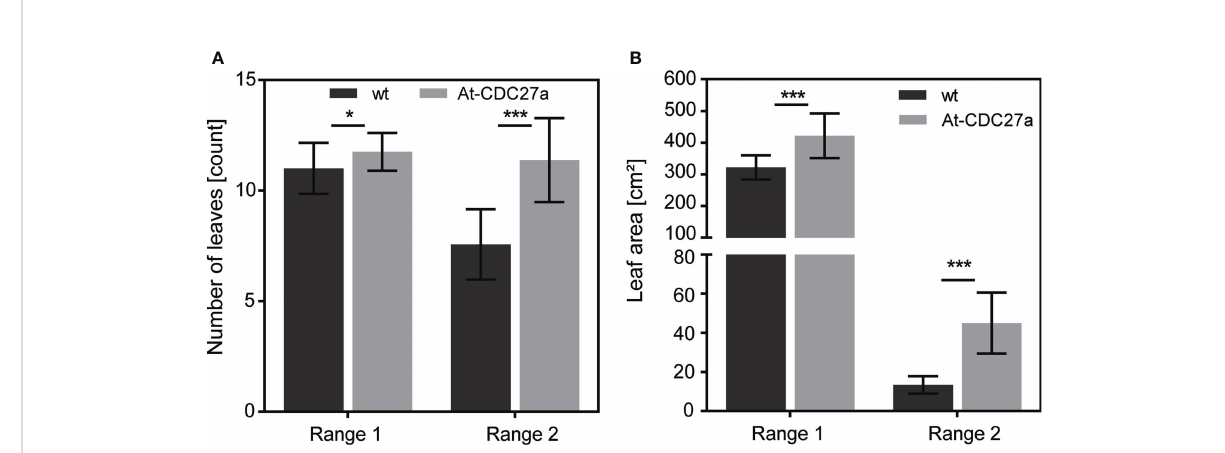
FIGURE 3 Leaf-related parameters of the At-CDC27a-29 transgenic line. Non-transgenic and transgenic plants were grown in the greenhouse conditions and number of leaves and leaf area per plant were determined after 4 weeks of cultivation. (A) Assessment of primary and axillary leaf number per plant. (B) Total leaf area for primary and secondary leaves. Values represent the means with standard deviation (n = 16). Asterisks indicate signi fi cance as determined by the unpaired T-test, with * and *** denoting p < 0.05 and p < 0.001,